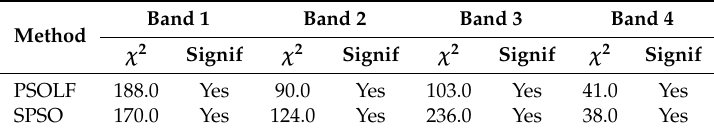
Table 9. Statistical significance of improvement of accuracy of the proposed LIPSO using McNemar’s Test [52] on Dubai City Dataset. χ 2 values with one degree of freedom and 95% confidence, p < 0.05, Signif =